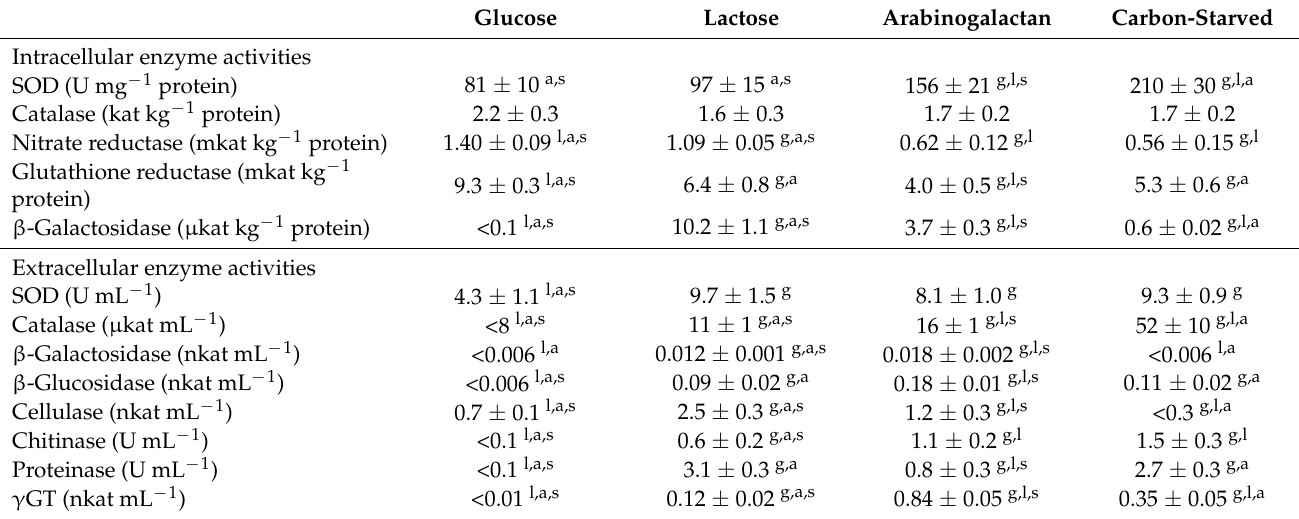
Figure 1. Growing and metabolic activity of the studied A. nidulans THS30 cultures. Changes in the MTT-reducing activity ( A ) and DCM ( B ) of the strain were characterized in cultures growing on glucose ( • ), in the absence of any carbon source ( ), on lactose ( (cid:4) ), or on arabinogalactan ( (cid:3) ). Mean ± SD values calculated from three biological replicates are presented. The MTT-reducing activity (cid:35) of 12 h cultures was significantly higher (Student’s t -test, p < 0.05) than that of the 4 h cultures. The DCM of the 12 h glucose, lactose, or arabinogalactan-containing cultures was significantly higher (Student’s t -test, p < 0.05) than that of the 0 h cultures. g, l, a, s —Significant difference (Student’s t -test, p < 0.05) from the data of cultures containing glucose, lactose, arabinogalactan, or no carbon source, respectively. Table 1. Enzyme activities of the studied A. nidulans THS30 cultures. Glucose Lactose Arabinogalactan